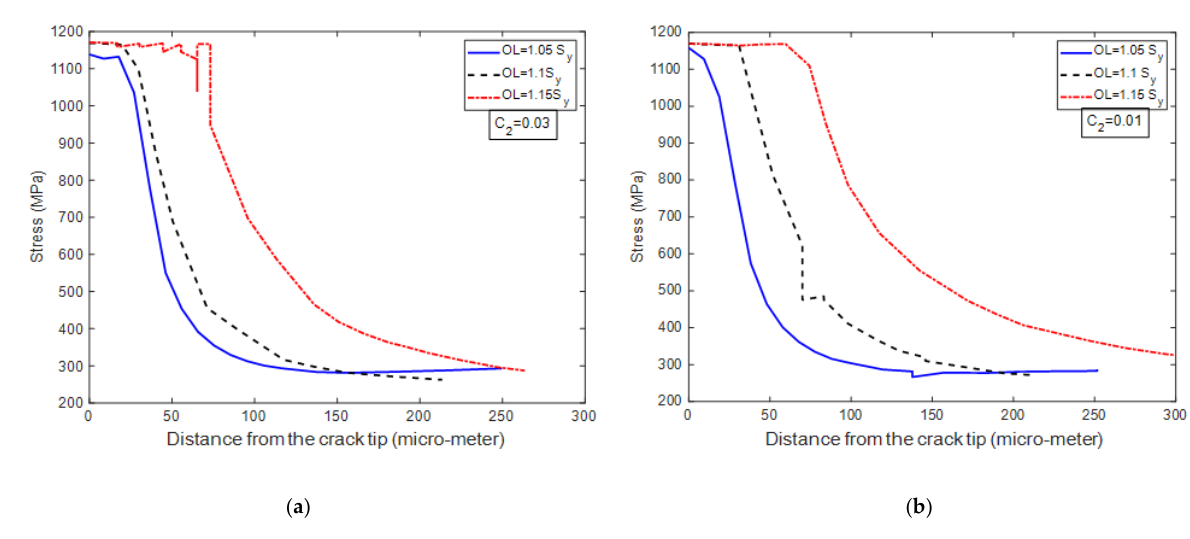
Figure 22. Stress distribution along the path below the tip of the crack for ( a ) C 2 = 0.03 and ( b ) C 2 = 0.01, with a residual stress of −80 MPa.